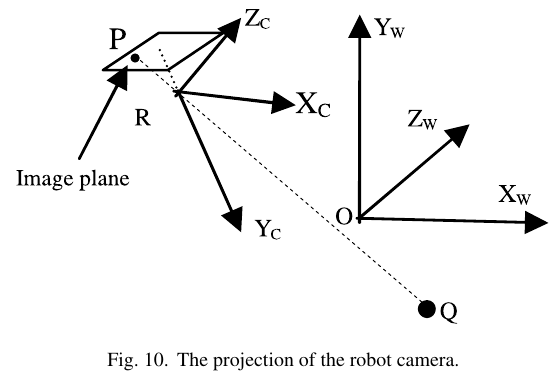
Fig. 10. The projection of the robot